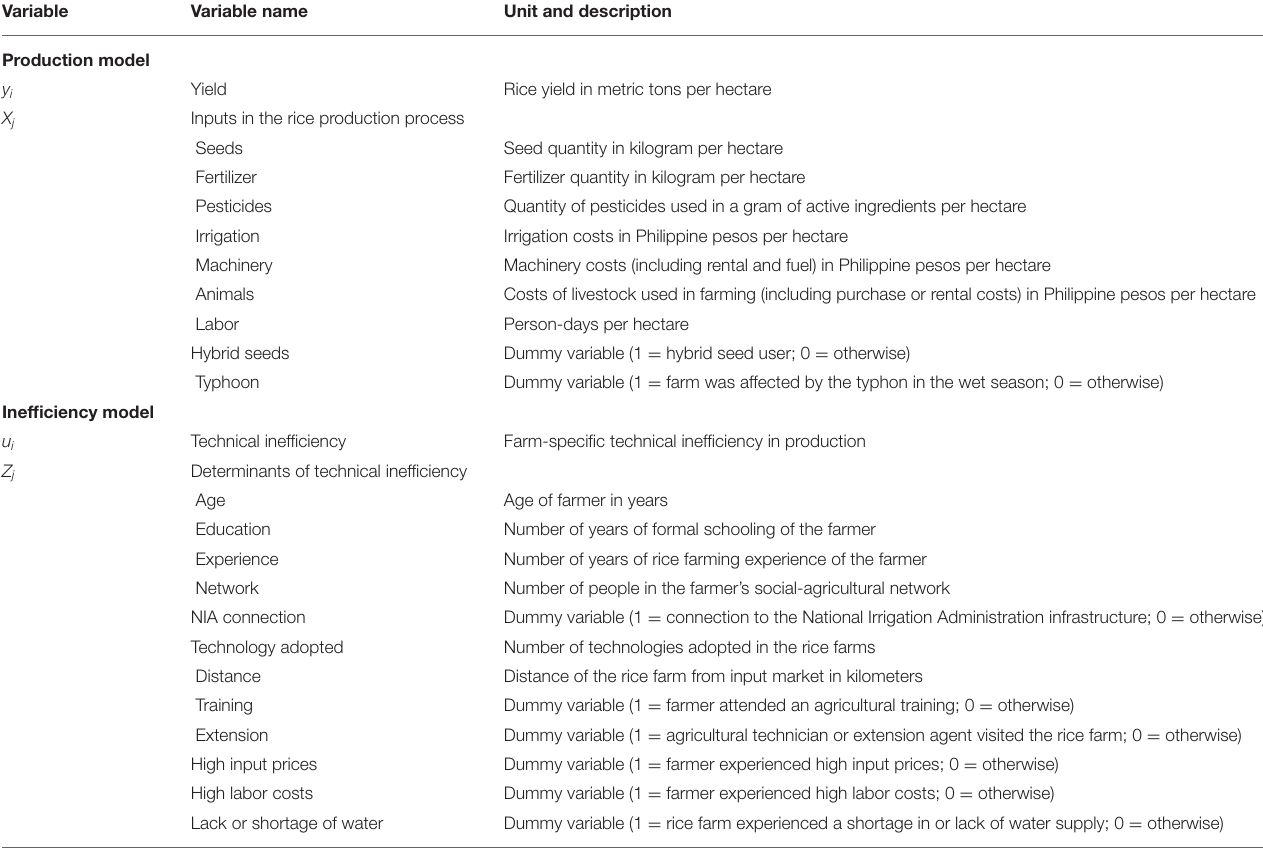
TABLE 1 | Description of the variables in the production and technical efficiency models.